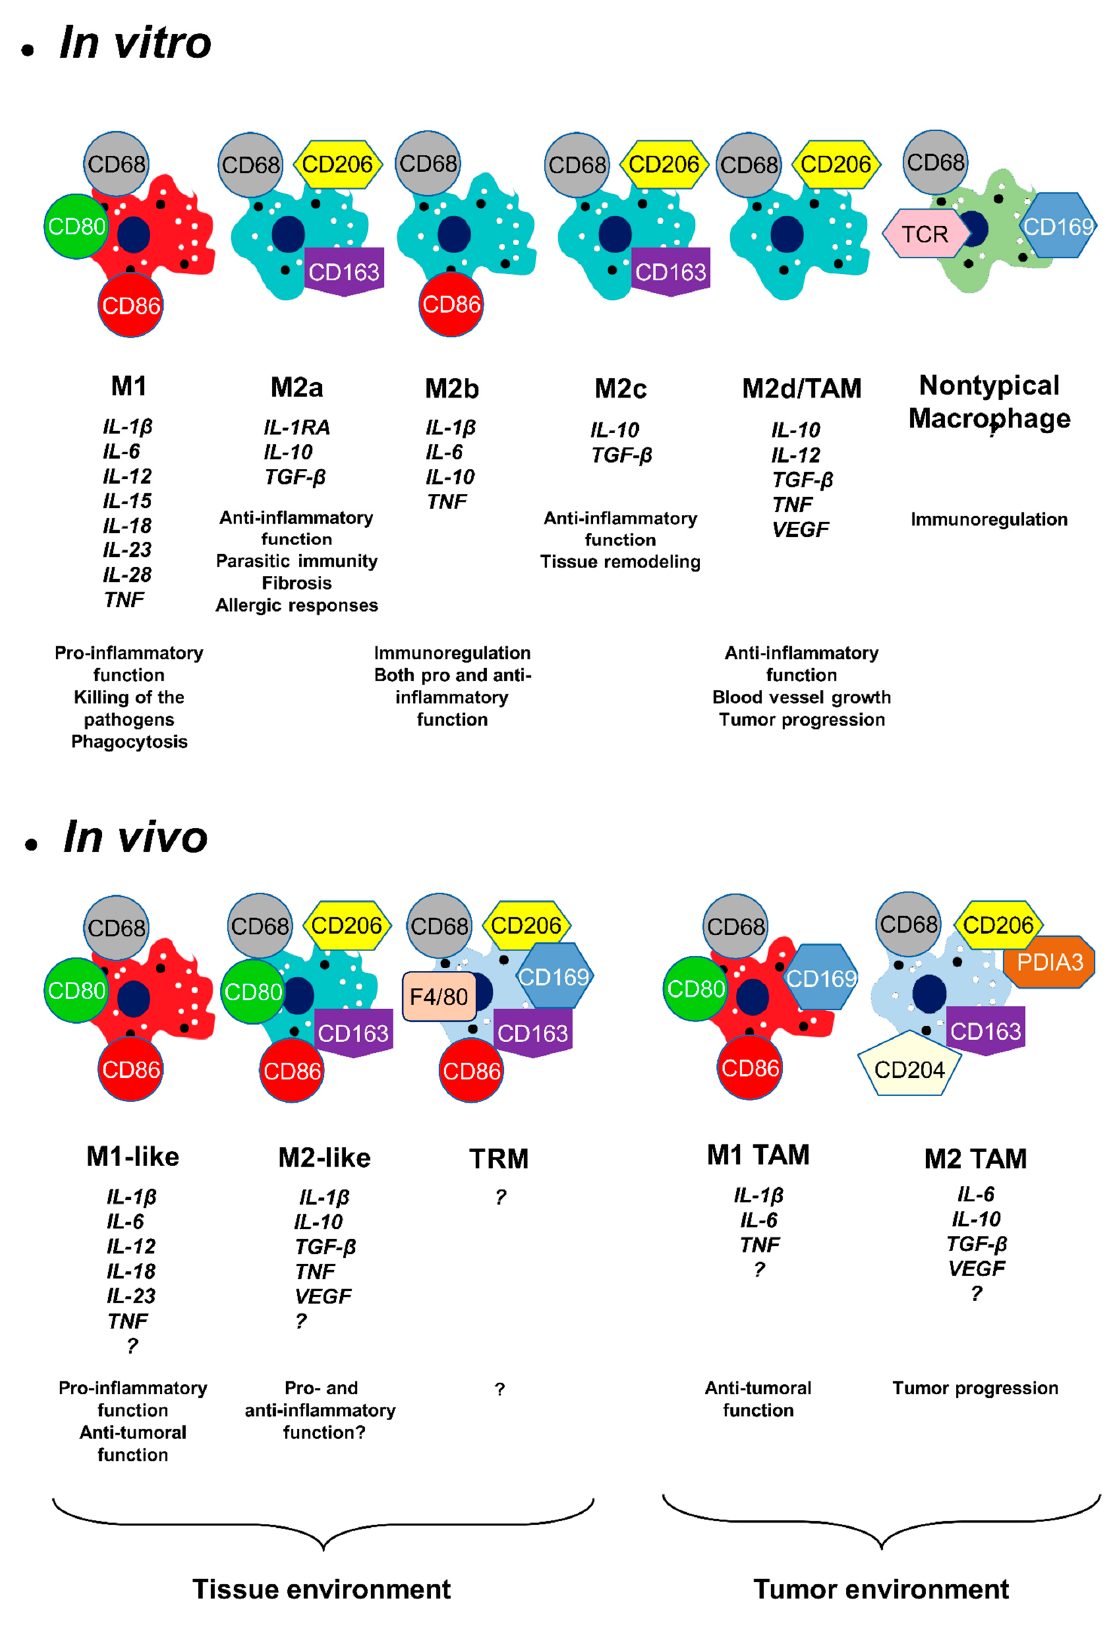
Figure 1. Macrophage polarization sub-types. Different cytokine expressions and functions of the macrophage populations in vitro and in vivo. Tissue Resident Macrophage (TRM), Tumor Associated Macrophage